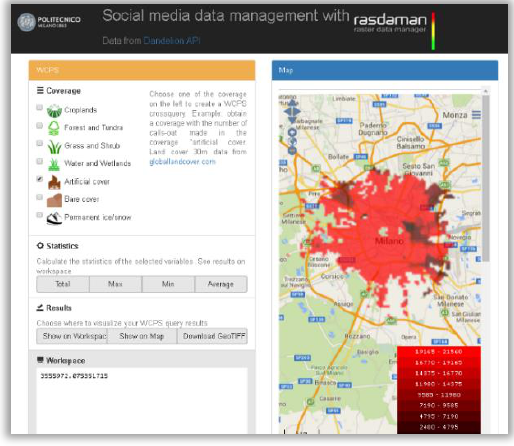
Figure 6. Social media data management web